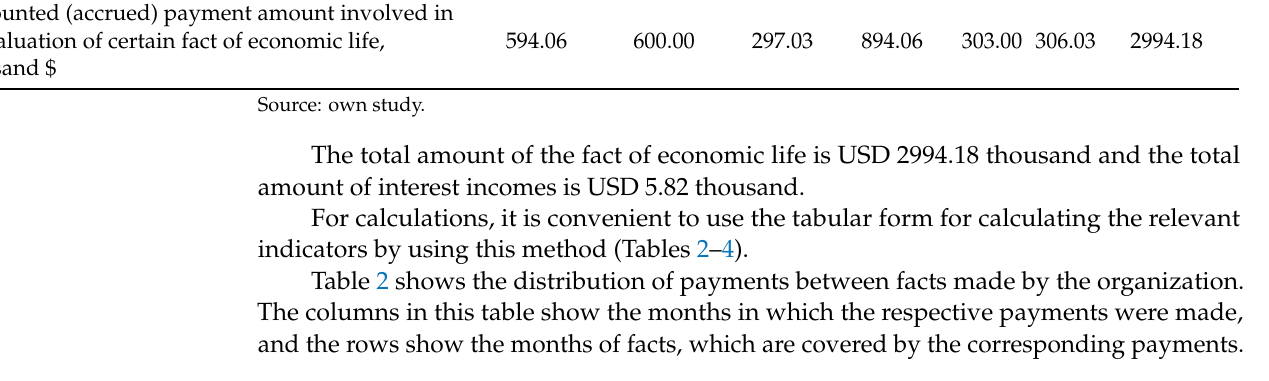
Table 2. Matrix of facts and payments, thousand